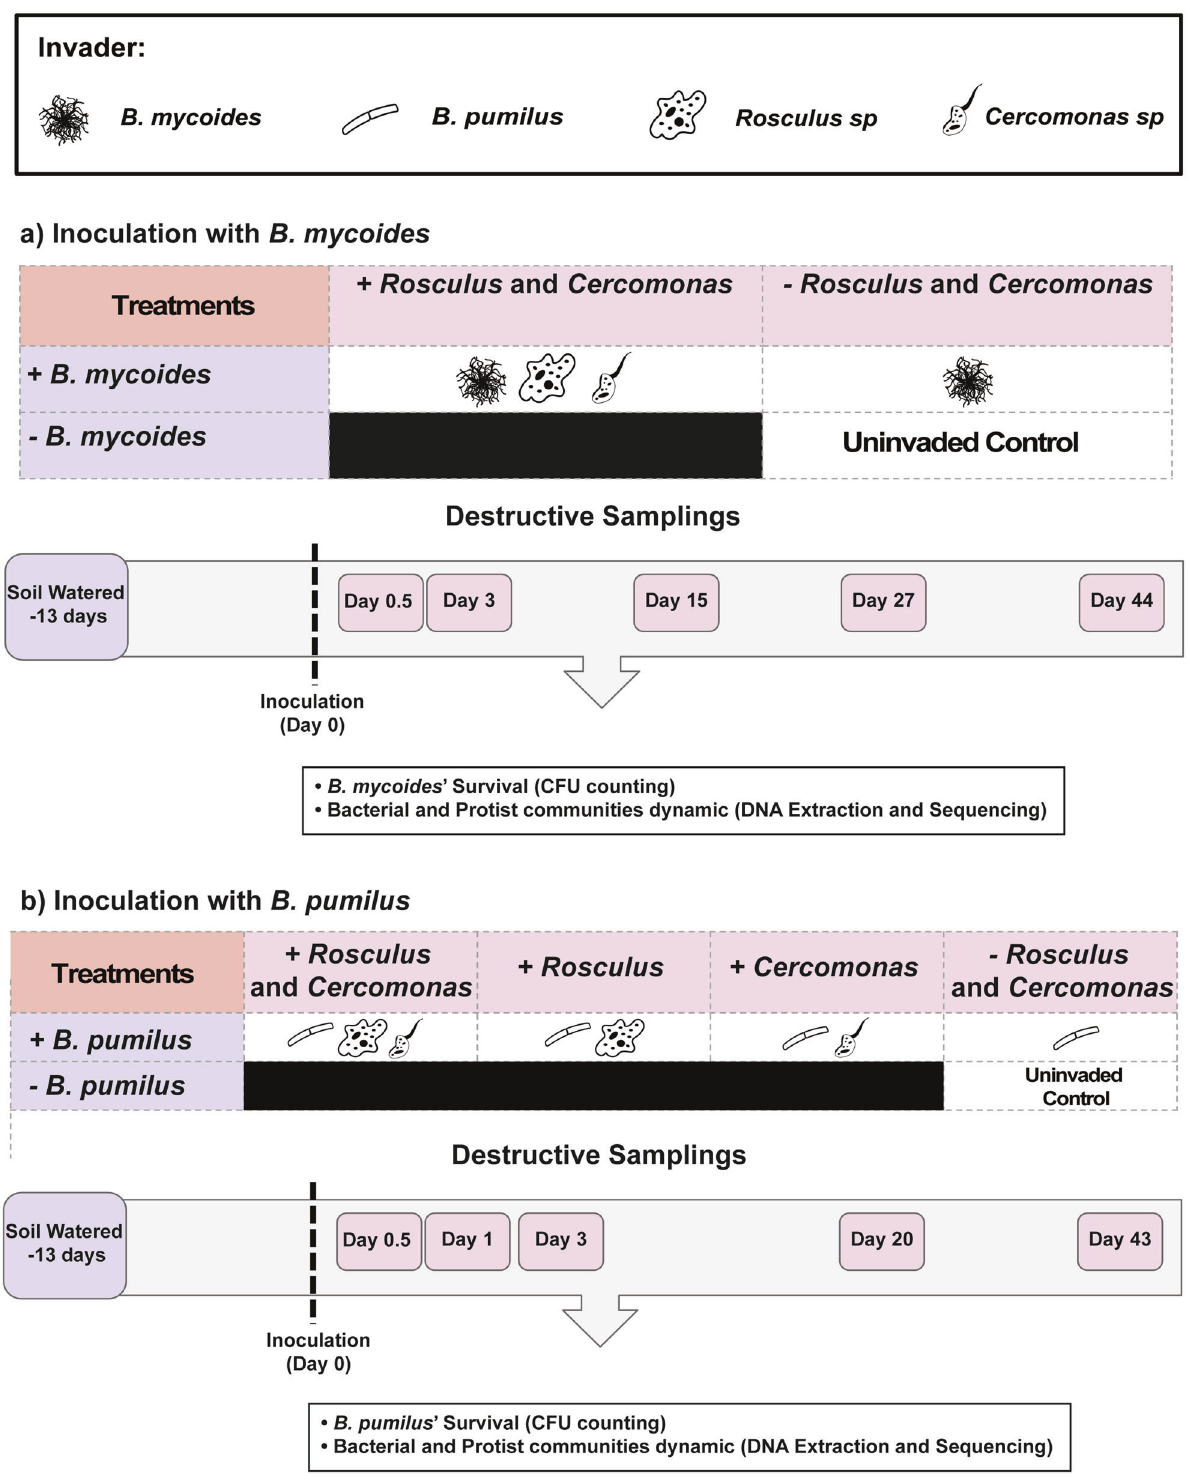
Fig. 1 Summary of the experimental design for the experiments. ( a ) inoculated by Bacillus mycoides M2E15 and ( b ) B. pumilus ECO-B-02, with or without sample according to their unique barcode by the UMGC. The split sequences for each sample were paired-end merged, denoised, derepli- cated, and trimmed using DADA2 [39]. This tool also fi lters chimeric sequences and removes primer sequences and singleton. For bacterial 16S rRNA gene sequences, DADA2 trimmed the sequence at positions 254 bp